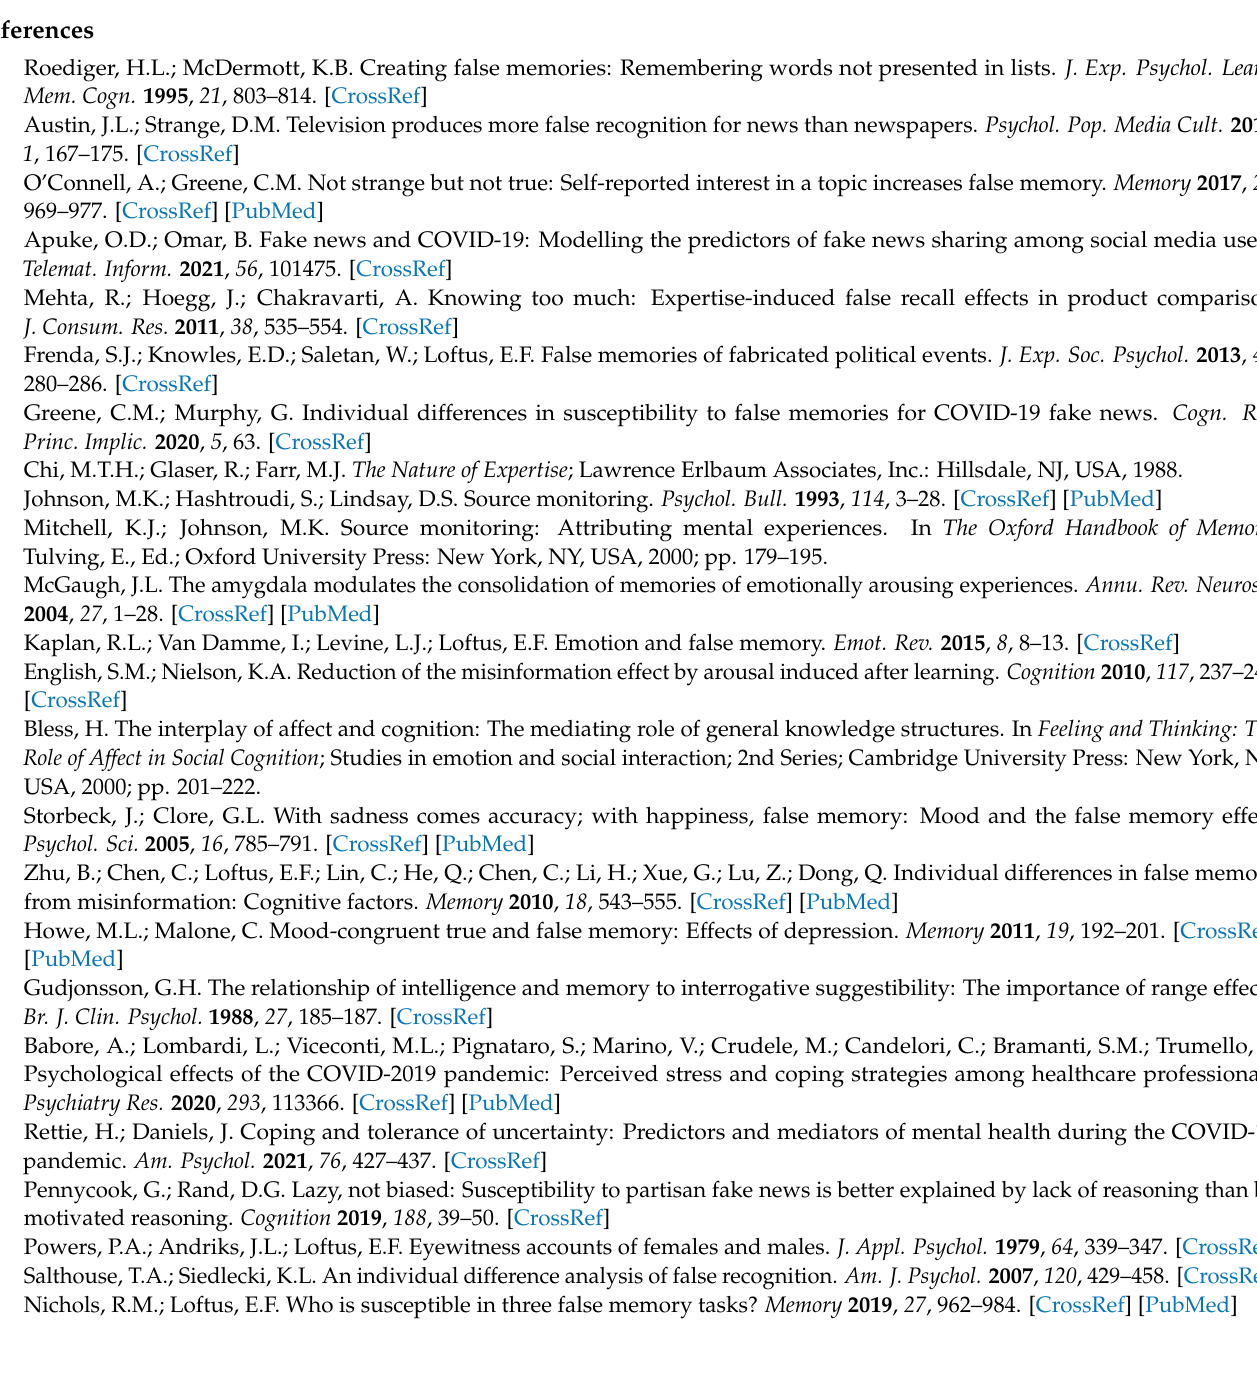
Figure A8. Symptoms. Figure A8.